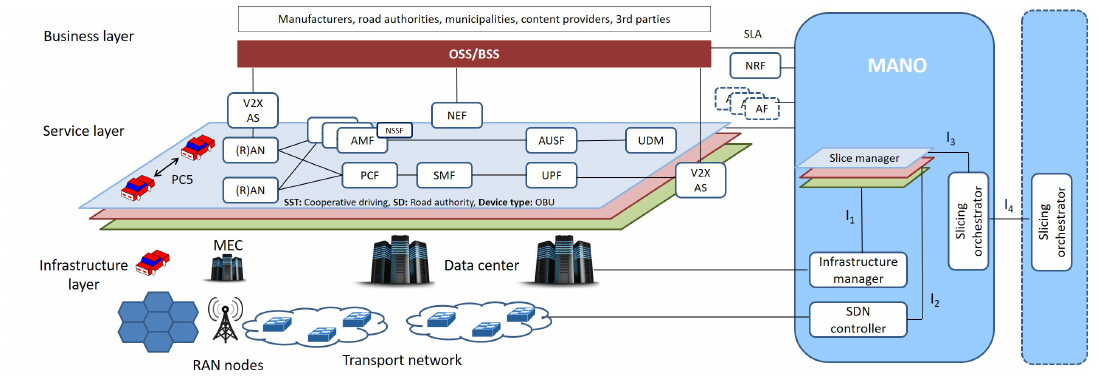
Figure 2. Network slicing framework and slice instantiation for cooperative driving services.